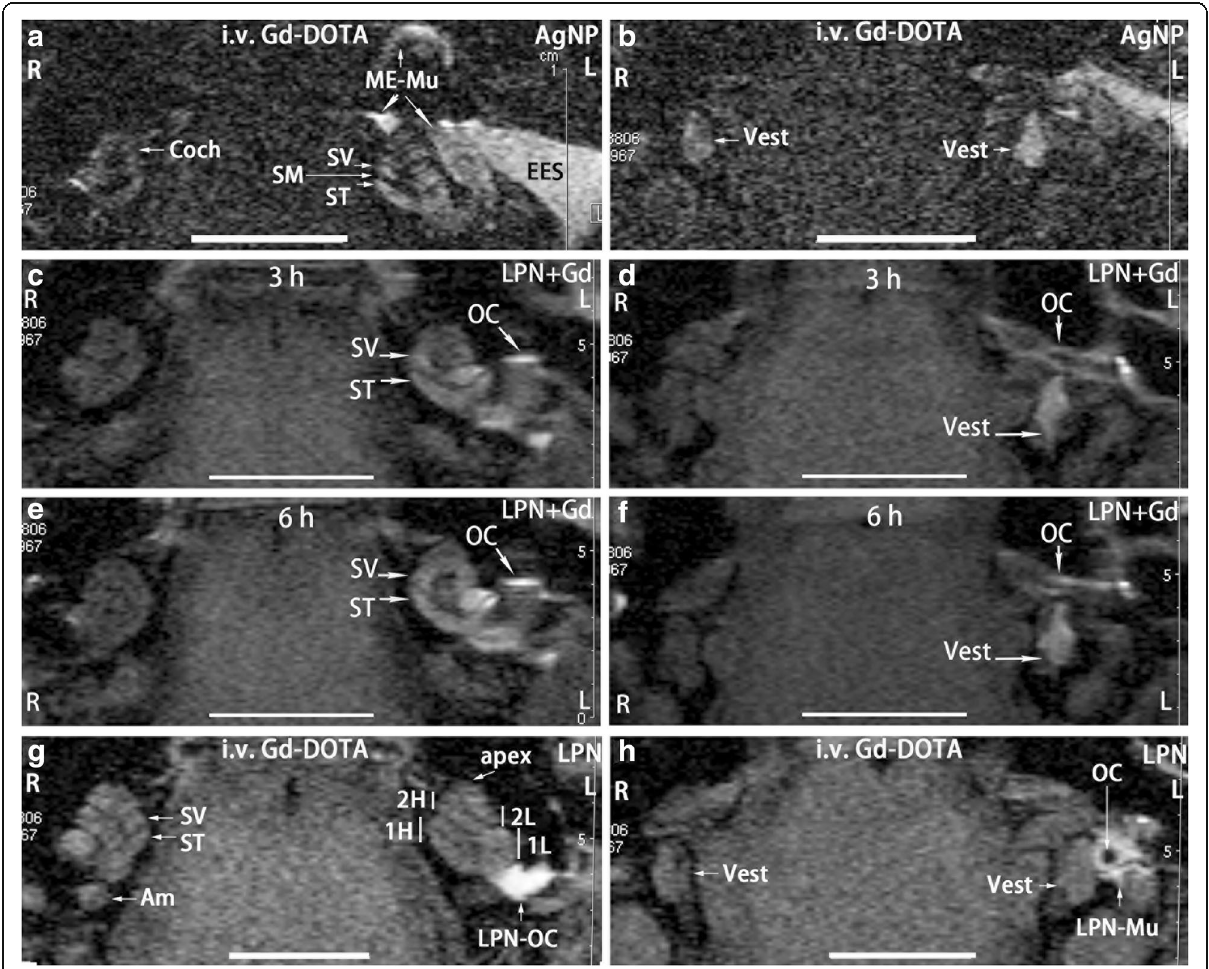
Fig. 2 Gadolinium-enhanced MRI of rat inner ear after liposome nanocarrier (LPN) administration. In all animals, nanomaterials were injected onto the medial wall of left middle ear cavity. The positive control was imaged in rats at 2 h post-intravenous injection of Gd-DOTA secondary to transtympanic injection of silver nanoparticles (AgNPs) 5 h in advance ( a , b ). Dynamic distribution of LPNs in the middle and inner ears was shown in c , d , e , f by transtympanic injection of Gd-DOTA-containing LPN without intravenous administration of Gd-DOTA. The impact of empty LPNs on the biological barrier was shown by MRI at 2 h post-intravenous injection of Gd-DOTA (i.v. Gd-DOTA) in rats receiving transtympanic injection of LPN 5 h in advance ( g , h ). Am ampullar of posterior semicircular canal, Coch cochlea, EES external ear skin, L left ear, LPN-Mu LPN in the middle ear mucosa, LPN-OC LPN on the ossicular chain ( OC ), ME-Mu , middle ear mucosa, R right ear, SM scala media , ST scala tympani, SV scala vestibuli, Vest vestibulum, 1H basal higher turn of cochlea, 1L basal lower turn of cochlea, 2H second higher turn of cochlea, 2L second lower turn of cochlea. Scale bar =5